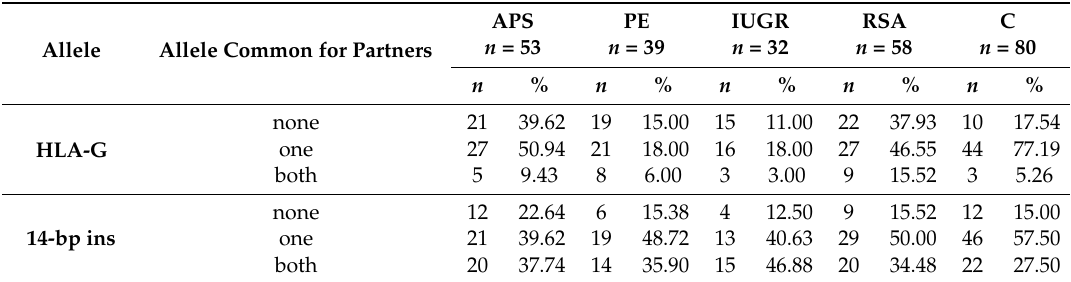
Table 7. The frequencies of the HLA-G common alleles and the 14-bp ins/del polymorphism in the 3 (cid:48) -UTR of the HLA-G gene in the parental pairs with a pregnancy complicated by antiphospholipid syndrome, preeclampsia, intrauterine growth restriction, or recurrent spontaneous abortion and in the control